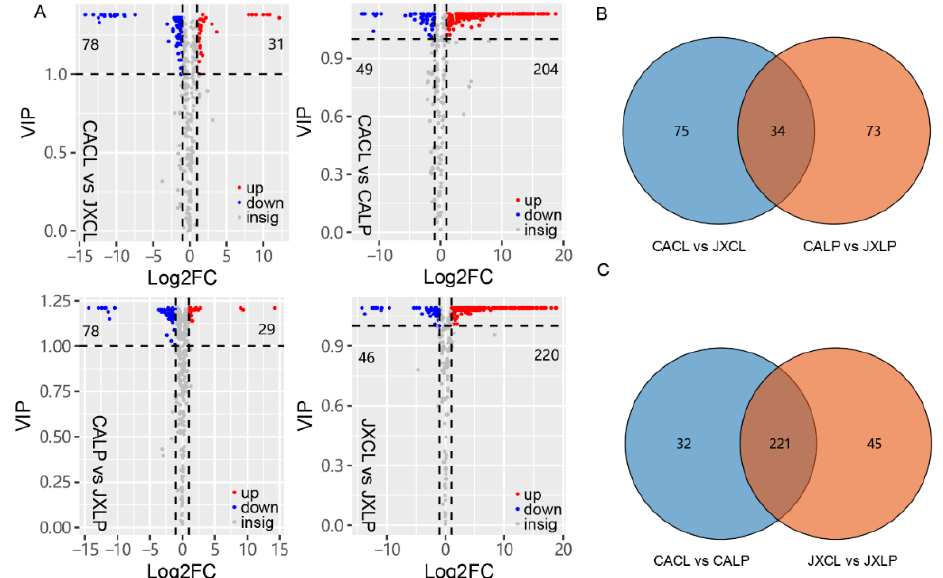
Figure 3. The number of differentially accumulated metabolites (DAMs) in CL and LP of “CA” and “JX”. ( A ) Volcano plots depicting the up- and down- DAMs in the paired comparisons based on the criterions of VIP > 1 and Log 2 FC ≥ 1 or ≤ −1. VIP, variable importance in projection; FC, fold change. ( B ) Venn diagram showing the common or specific DAMs in CL and LP comparing “JX” with “CA”. ( C ) Venn diagram showing the common or specific DAMs in “CA” and “JX” comparing LP with CL. “CA”, China Antique; “JX”, JianXuan-17; CL, cotyledon; LP; lotus plumule; VIP, the value of the variable importance in the project.